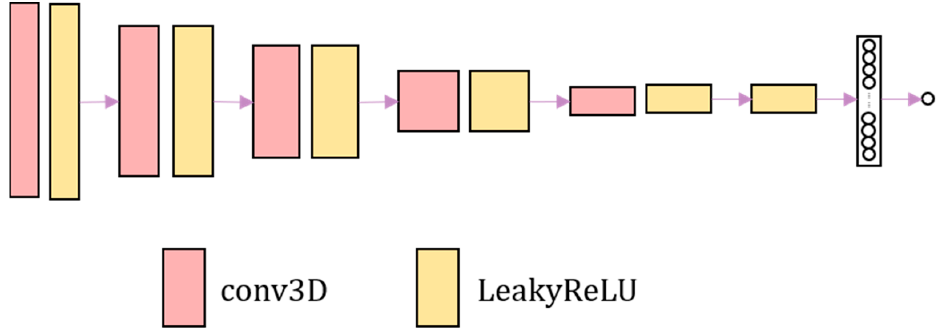
Figure 2. The overall framework of the adversarial network. The adversarial network consists of convolution and LeakyReLU activation